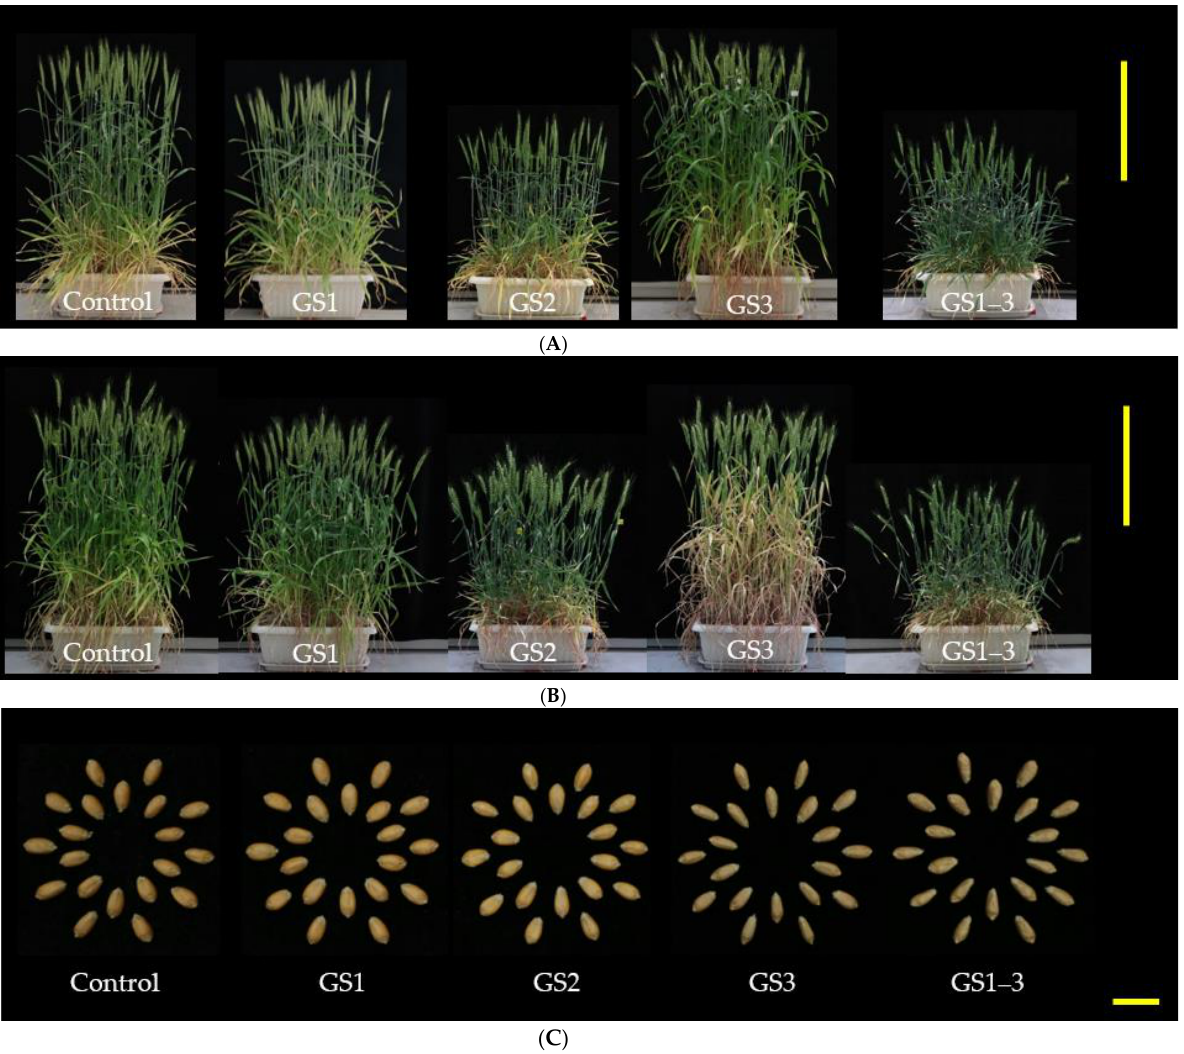
Figure 2. Effect of high temperature during each growth stage on plant and seed morphology. ( A , B ) Each plant at ( A ) anthesis and ( B ) 14 days post-anthesis. ( C ) Harvested seeds. Bars: plants, 50 cm; seeds, 1 cm.